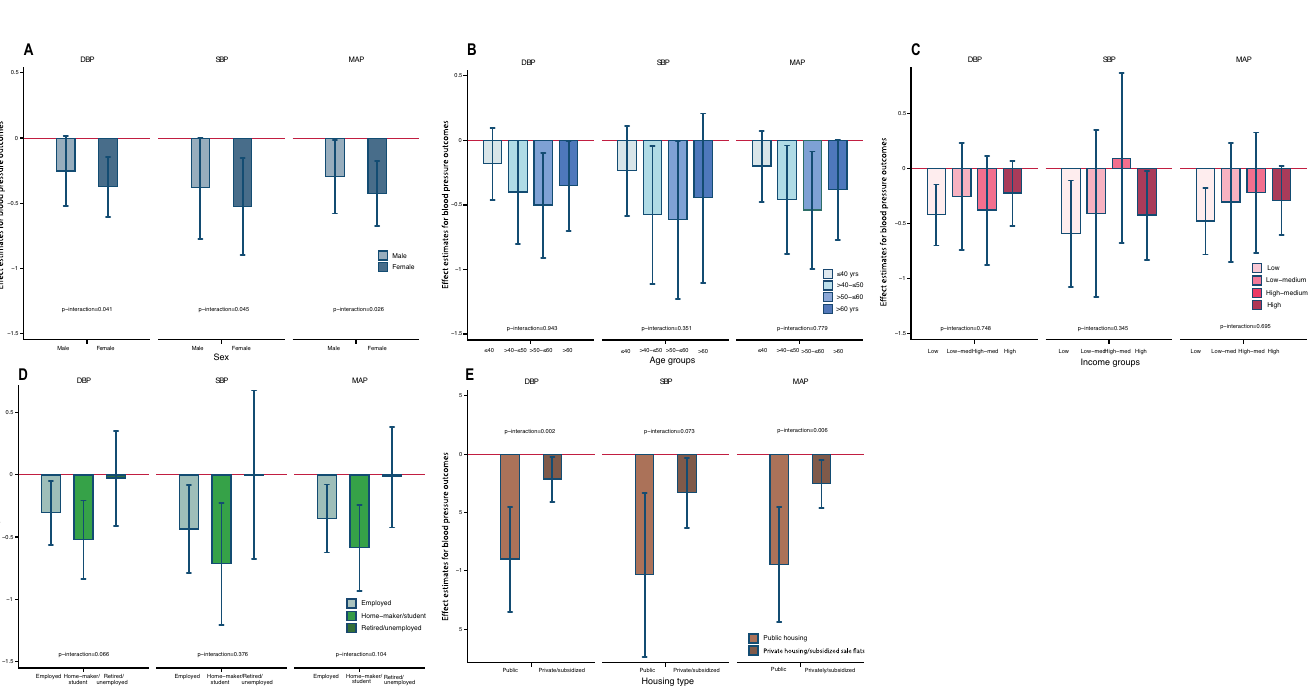
Fig 1. Association between liveable floor area and blood pressure outcomes by (A) sex, (B) age groups, (C) income categories, (D) employment status, and (E) housing type in the second wave of FAMILY Cohort. Models adjusted for sociodemographics (age, sex, marital status, employment status, educational attainment, and income), lifestyle (smoking status, alcohol intake frequency, number of family members, shared living, and housing type), comorbidities (obesity and cardiac heart disease), and environment (residential units per block, neighborhood-level residential density, housing floor level, and density of public transport and terrain). The vertical bars indicate the effect estimate ( β ), while the whiskers indicate 95% CI. The p -values are for the interactions between liveable floor area and population subgroups stratified by sex, age, income, employment status, and housing type. β , beta; CI, confidence interval; DBP, diastolic blood pressure; MAP, mean arterial pressure; SBP, systolic blood